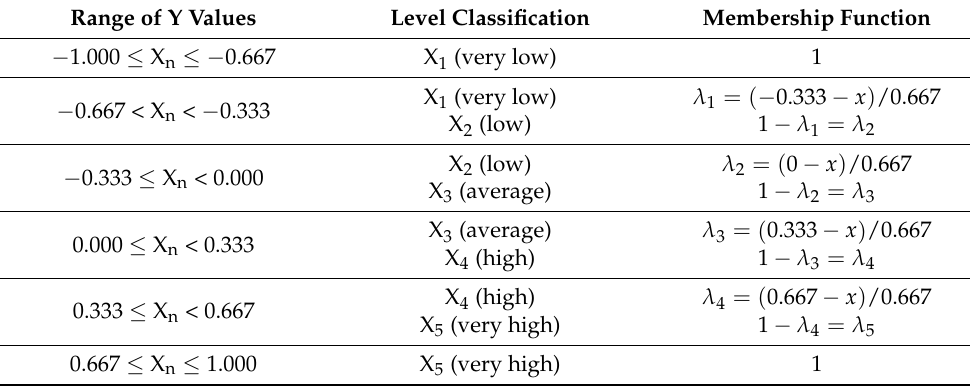
Table 2. Classification of the level of